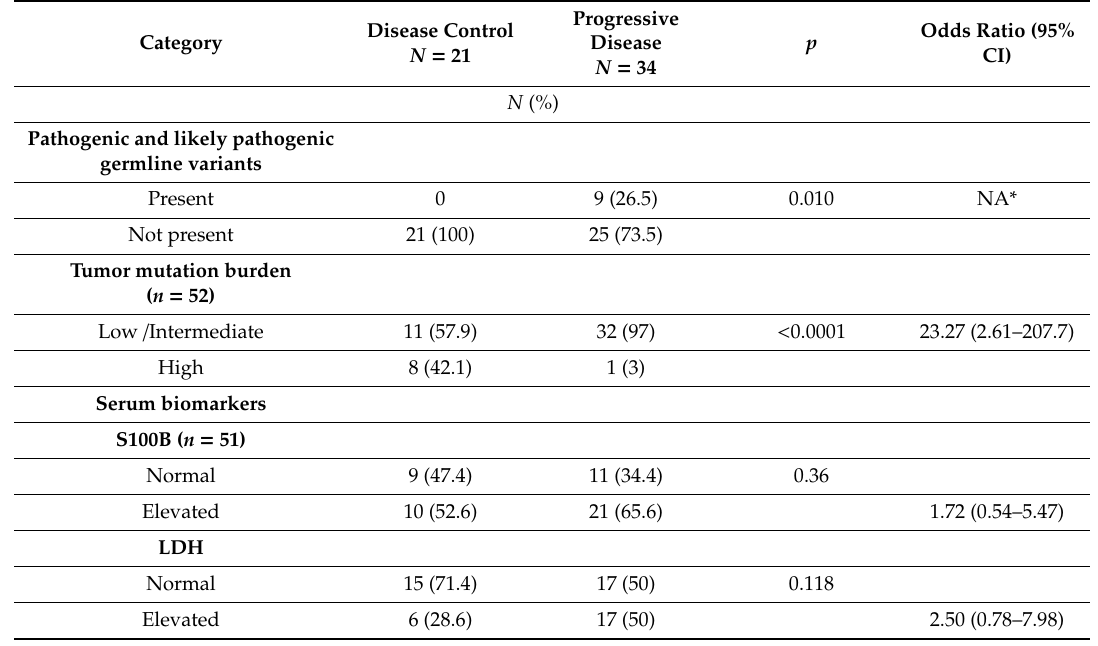
Table 3. Response to combined immunotherapy dependent on potential predictors ( n =